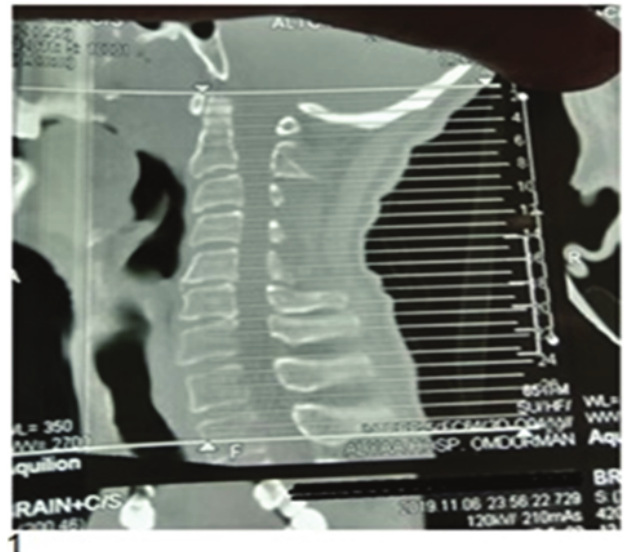
Figure 1 : CT scan of the patient’s neck. The spinous process of cervical vertebrae appears short.